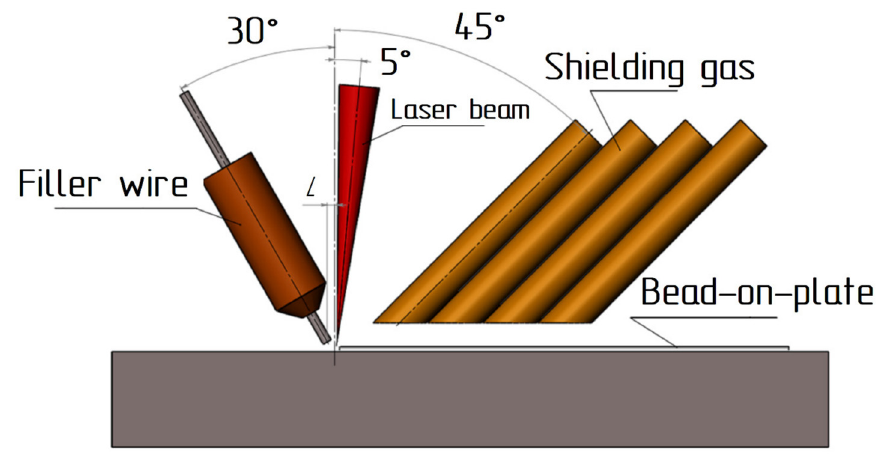
Figure 2. Scheme of laser cladding with filler wire.